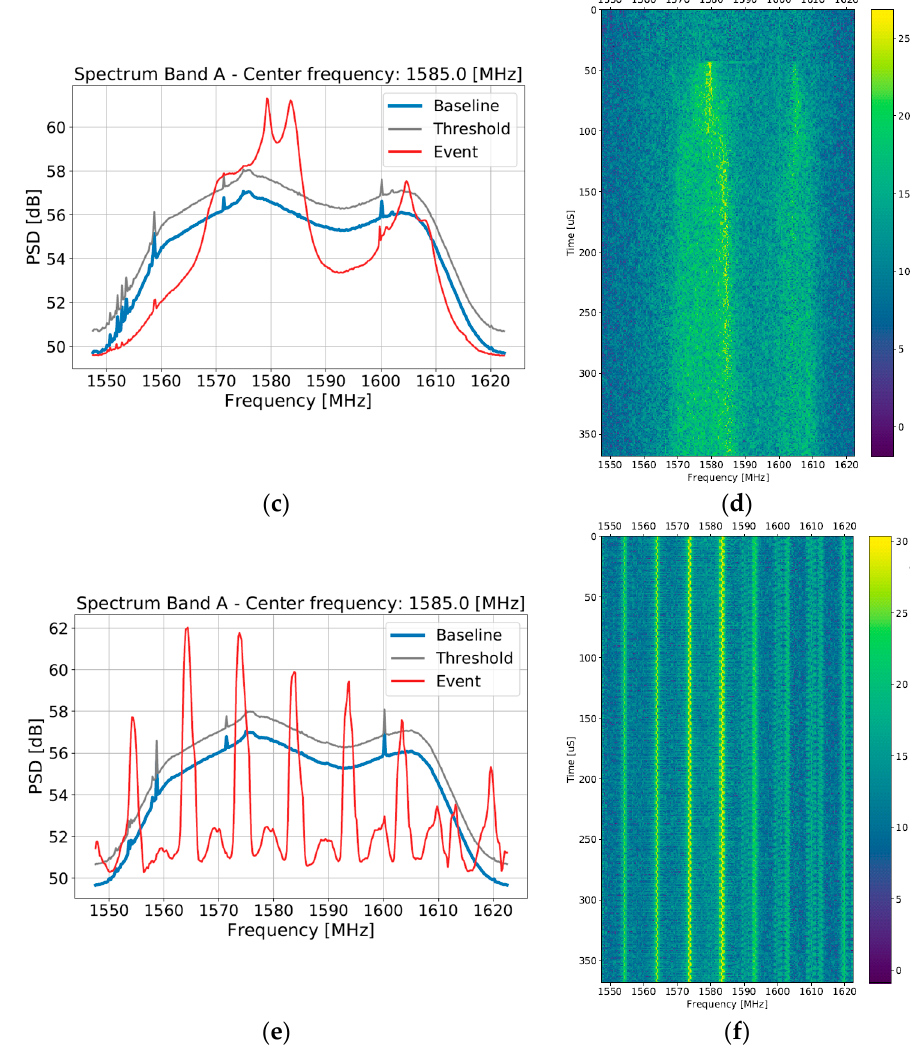
Figure 9. Examples of ( a , b ) wideband time-modulated signal using an exponential function; ( c , d ) non-stationary distribution of RFI potentially evidencing meaconing or spoofing; ( e , f ) modulated rake/multi-CW.